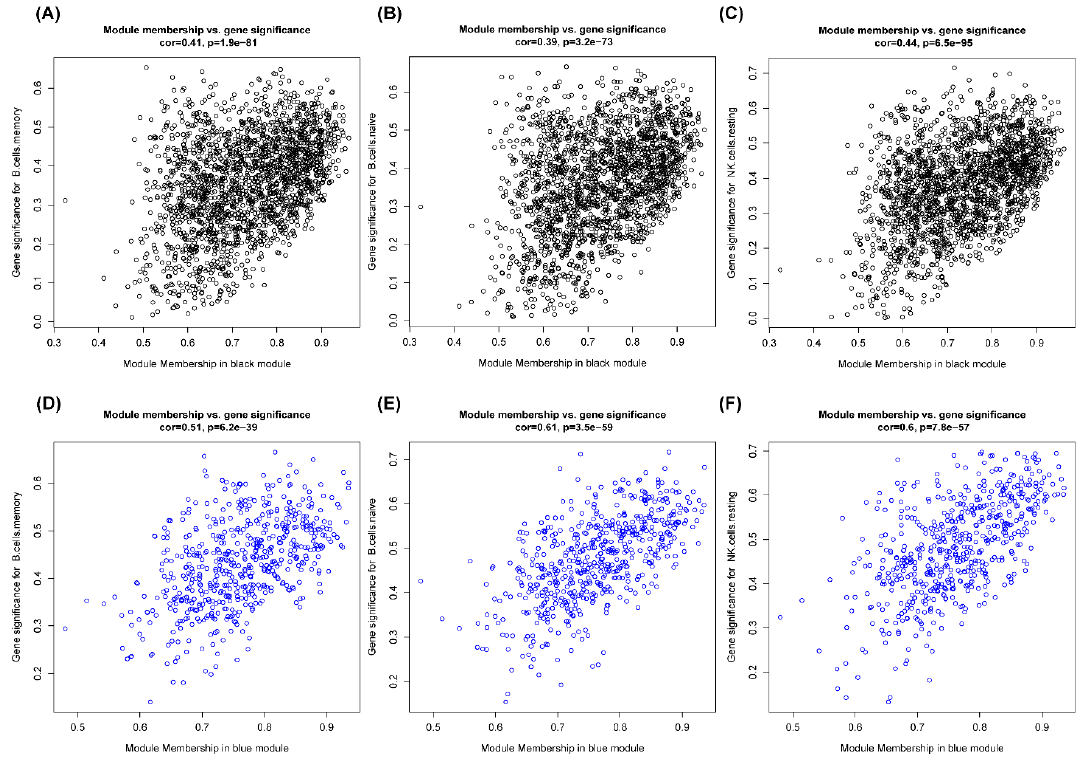
Figure 6. The scatter plots of module membership and gene significance for B cells and NK cells in the key modules. One dot represents one gene. ( A ) ROC curves of MYG1 . ( B ) ROC curves of FLOT1 . ( C ) ROC curves of GPX1 . ( D ) ROC curves of LINC00520 . ( E ) ROC curves of ZNF548 . ( F ) ROC curves of ATG13 . AUC > 0.7 indicates good effect.